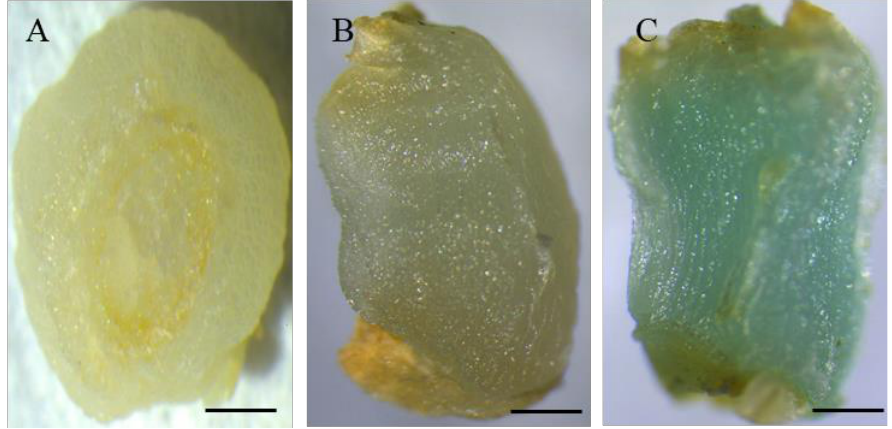
Figure 2. Histochemical staining of GUS transgenic calli. ( A ), wild type callus ( B ), transgenic calli. ( C ), Scale bar = 500 µ m. Table 5. The differentiation ratio of each orthogonal test group.